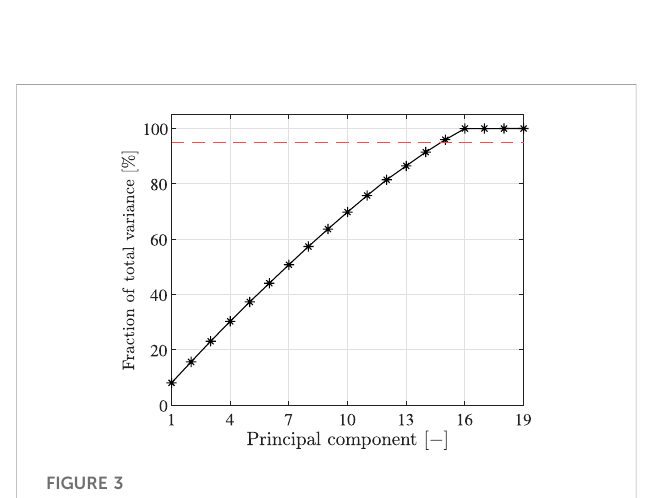
FIGURE 3 Numerical case study: cumulative percentage of total variance explained by the principal components of the mode shape baseline. Red dashed line: threshold value of